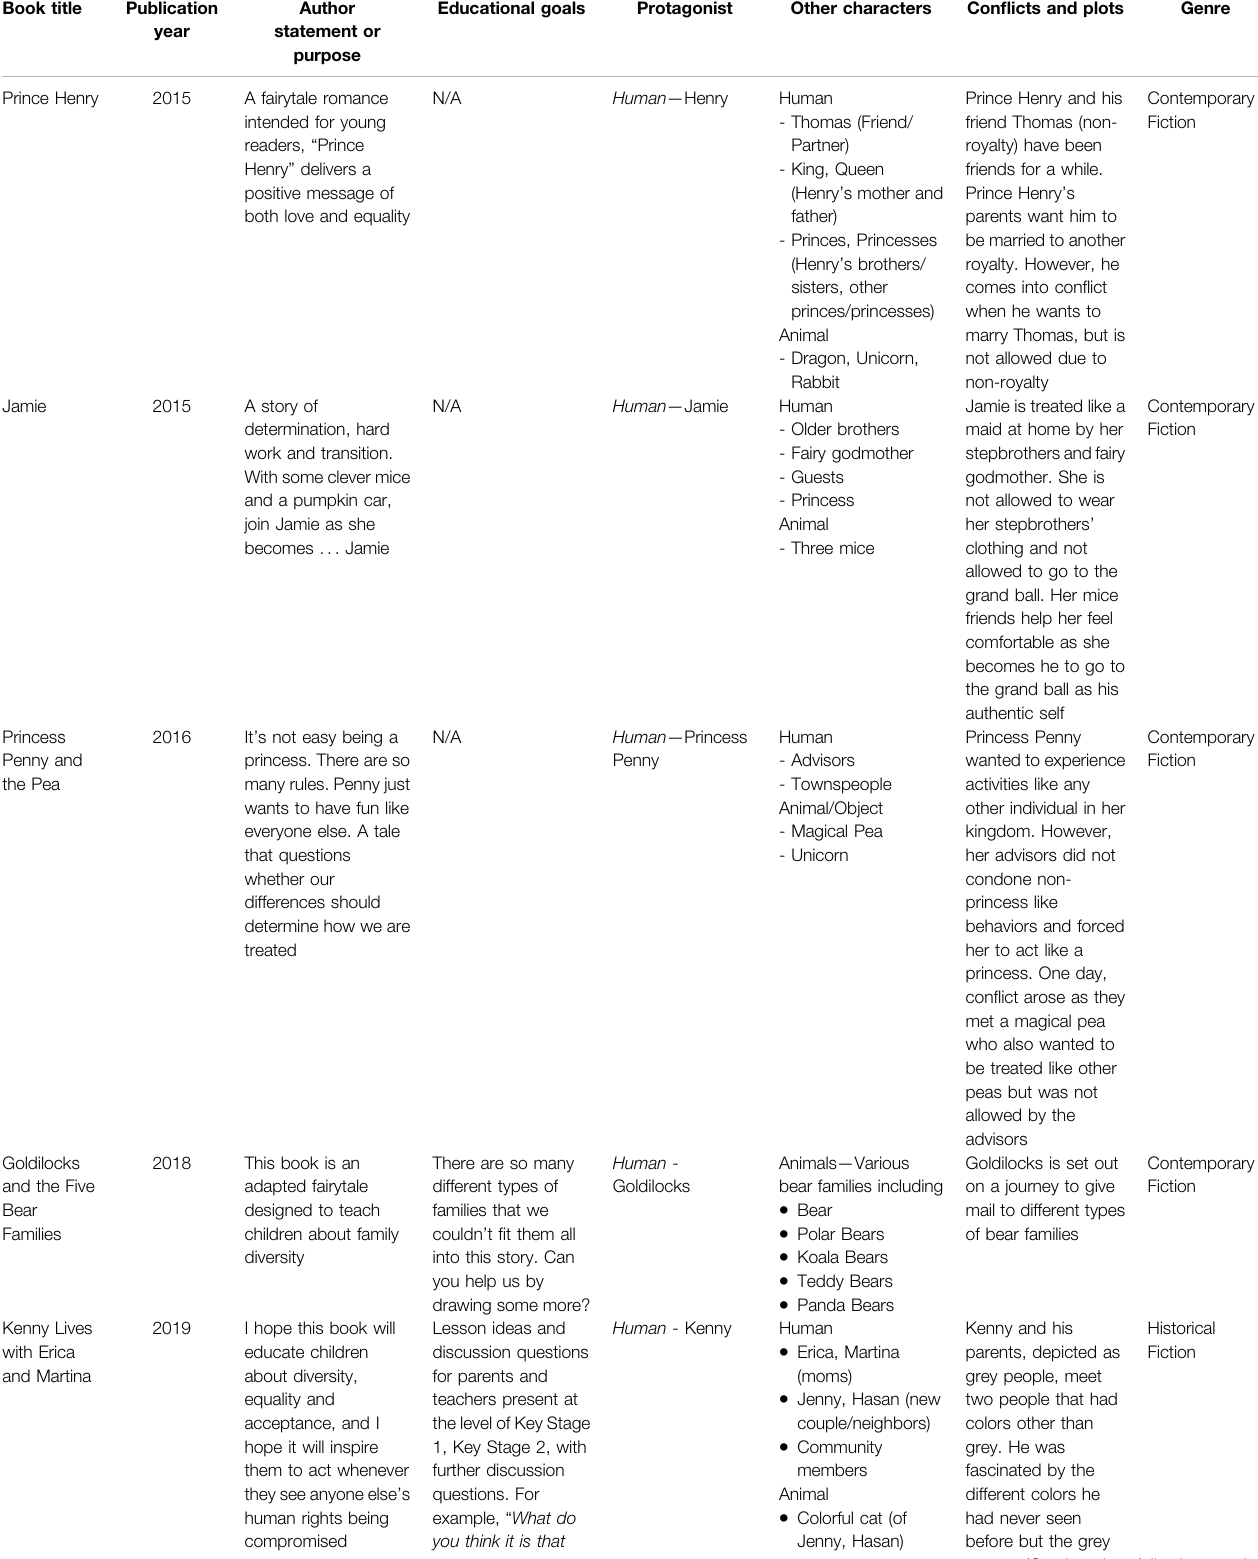
TABLE 1 | Summary of the fi ve LGBTQ-inclusive picture